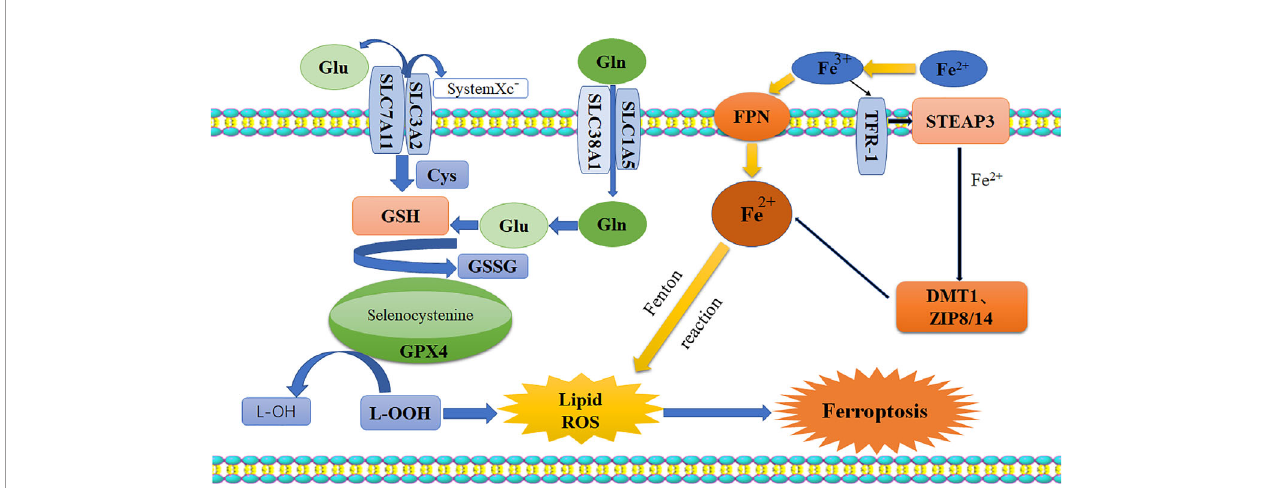
FIGURE 3 | Schematic diagram offerroptosis pathway. Glutamate and glutamine enter the cell body through system-xc, while Fe 2+ enters the cytoplasm through FPN. Their accumulation would break the balance in the cells, and the lipid ROS is generated by GPx4 and Fenton reaction, resulting in ferroptosis. Glu, glutamate; Gln, glutamine; Cys, cysteine; GSH, reduced glutathione; GSSH, oxidized glutathione; GPX4, glutathione peroxidase 4; ROS, reactive oxygen species; FPN, ferroportin; TFR-1, transferrin receptor-1; STEAP3, six-transmembrane epithelial antigen of prostate 3; DMTI, divalent metal transporter; ZIP8/14, zinc transporter